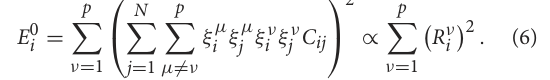
Algorithm 1 consisted of a heuristic optimization